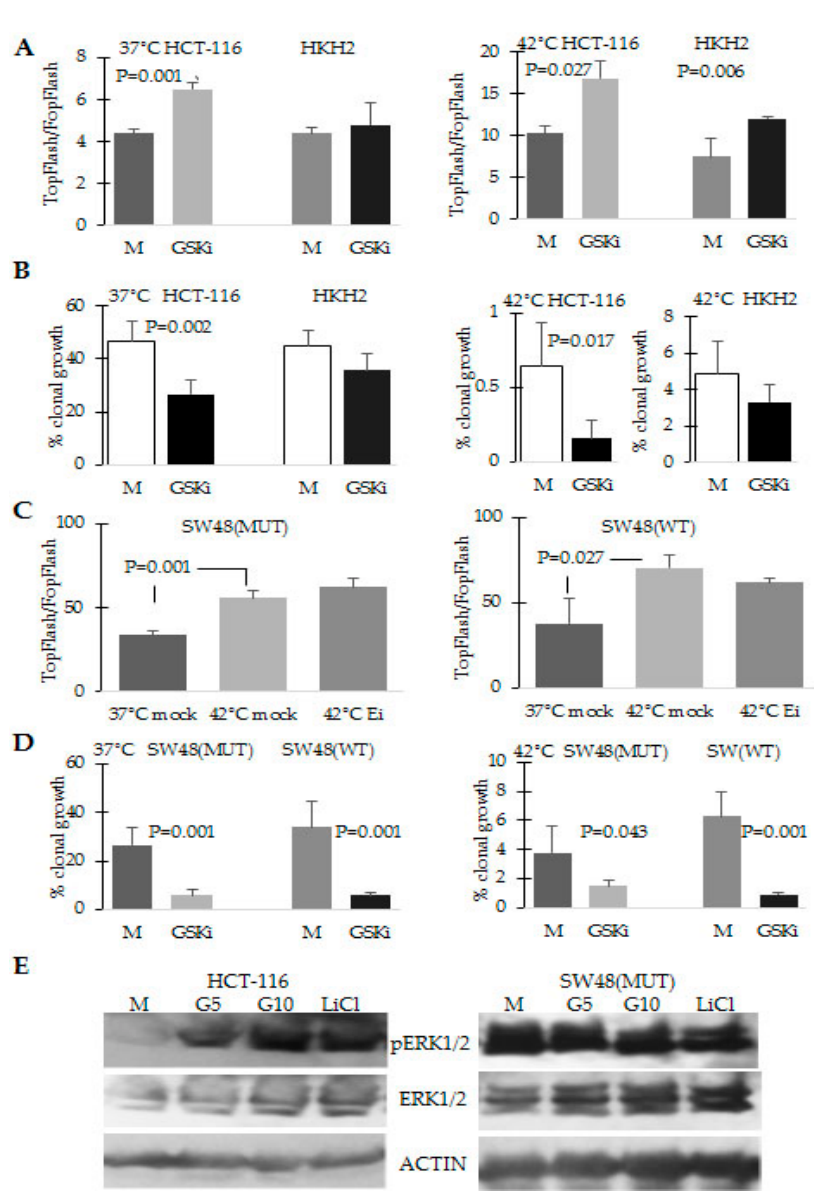
Figure 6. Increase of WNT/beta-catenin activity in HCT-116 cells results in higher levels of ERK1/2 activation and decreased ability for clonal growth at 42 ˝ C. ( A , C ) WNT/beta-catenin transcriptional activity was measured as in Figure 5 after exposure of the cells to mock treatment (M), 5 µ M of the GSK-beta kinase inhibitor (GSKi) TWS119, or 0.5 µ M AZD6244 (Ei) for 16 h. Three experiments with duplicate samples per treatment and condition (temperature) were performed; ( B , D ) Clonal growth analyses were performed as in Figure 1 by exposing the cells for 24 h to mock treatment or 5 µ M TWS119 (GSKi); ( E ) Representative Western blot analyses with total cell lysates of HCT-116 cells exposed for 16 h to 42 ˝ C and 5 or 10 µ M TWS119 (GSKi) and 20 mM lithium